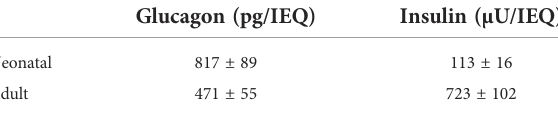
TABLE 1 Glucagon and insulin contents of neonatal and adult isolated porcine islets.